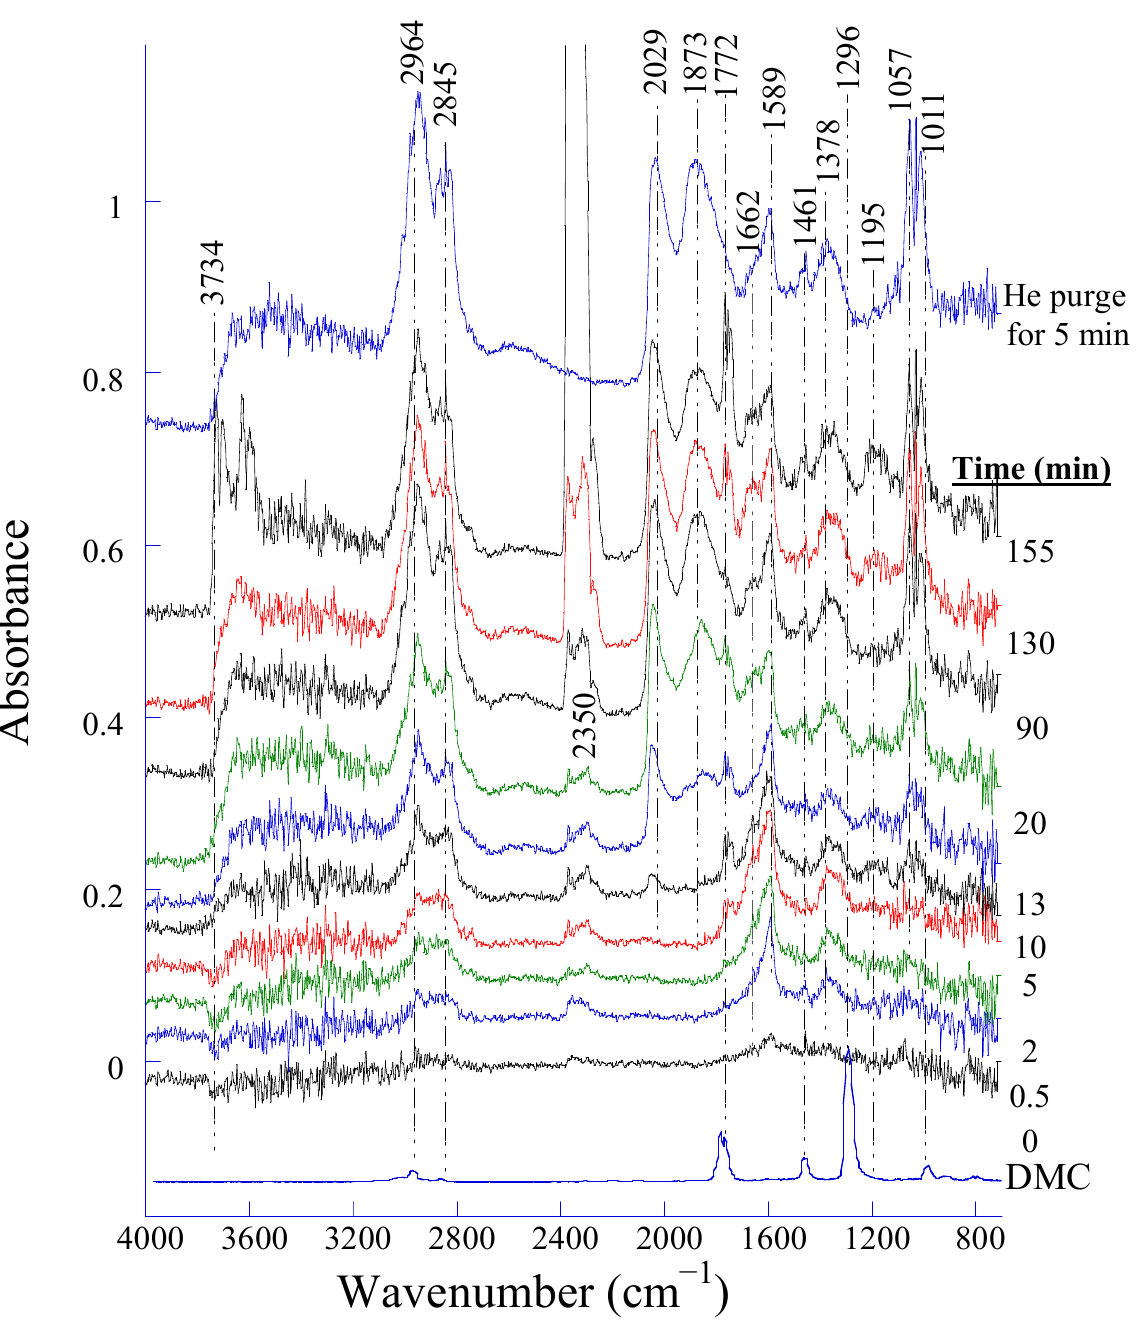
Figure 5- IR spectra during the methanol-CO 2 reaction over 5% Rh/Al 2 O 3 at 373 K. Figure 5. IR spectra during the methanol-CO 2 reaction over 5% Rh/Al 2 O 3 at 373